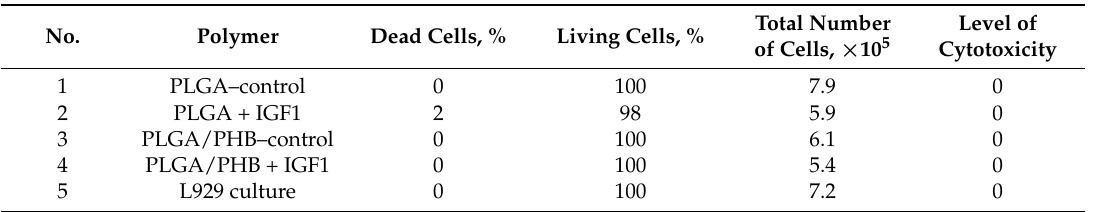
Table 8. Number of cells and level of cytotoxicity after 72 h of incubation—indirect method (polar